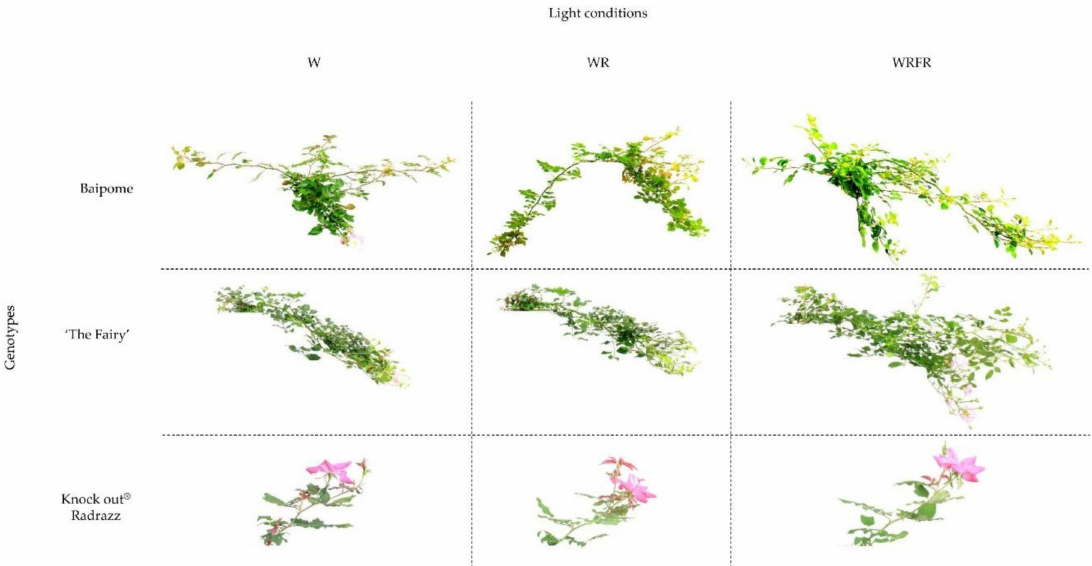
Figure 3. Overall shape of Baipome, ‘The Fairy’ and Knock Out ® Radrazz grown in a climatic chamber under three light conditions—W, WR, and WRFR—up to the ‘opened flower of the order 1 axis’ stage, corresponding to the end of cultivation (measurement point 2).